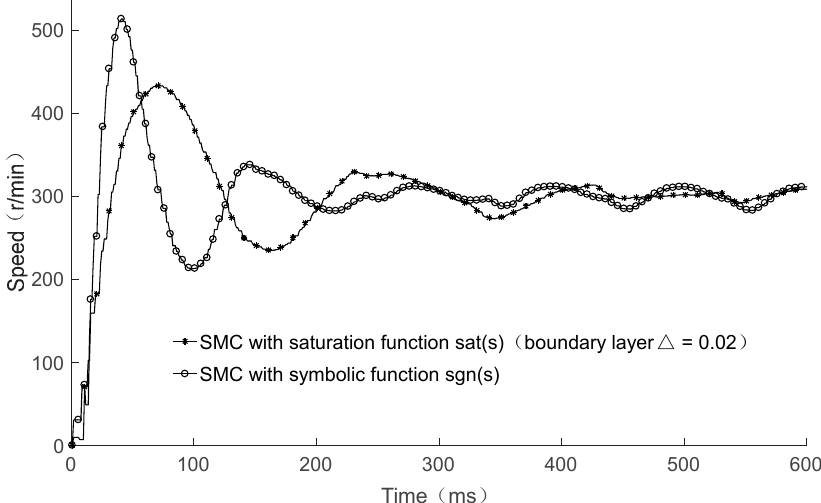
Figure 9. The experimental results of the starting performance of the PMSM.